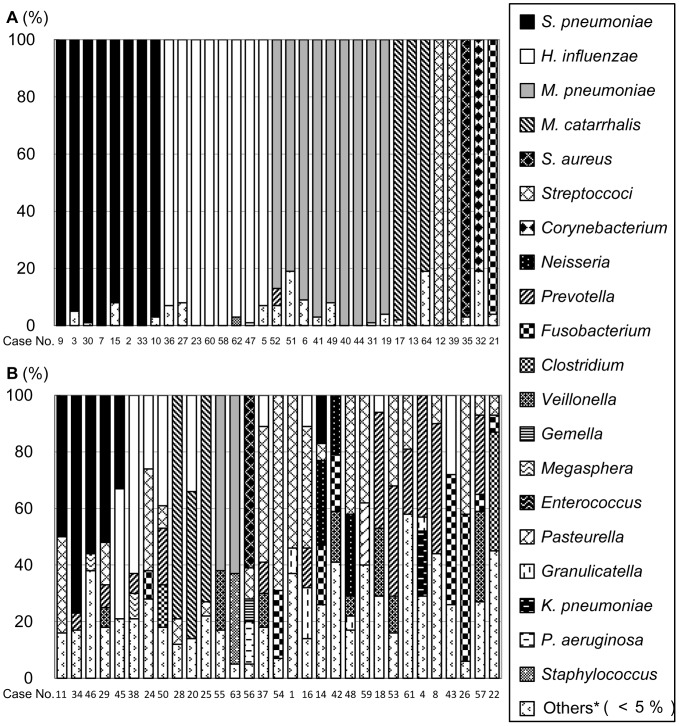
Percentage of detected phylotypes in “monobacterial dominant” and “mixed-bacterial” groups using the molecular method.The percentage of phylotypes in each sample in the 33 patients in the “monobacterial dominant group” (A) and the percentage of phylotypes in each sample in the 31 patients in the “mixed-bacterial group” (B). Streptococcus pneumoniae, Mycoplasma pneumoniae, Haemophilus influenzae, Moraxella catarrhalis, Staphylococcus aureus, Klebsiella pneumoniae, and Pseudomonas aeruginosa were shown as presumptive species, and the others were shown as presumptive genera. The phylotypes that dominated less than 5% in each library were classified as “Others.”